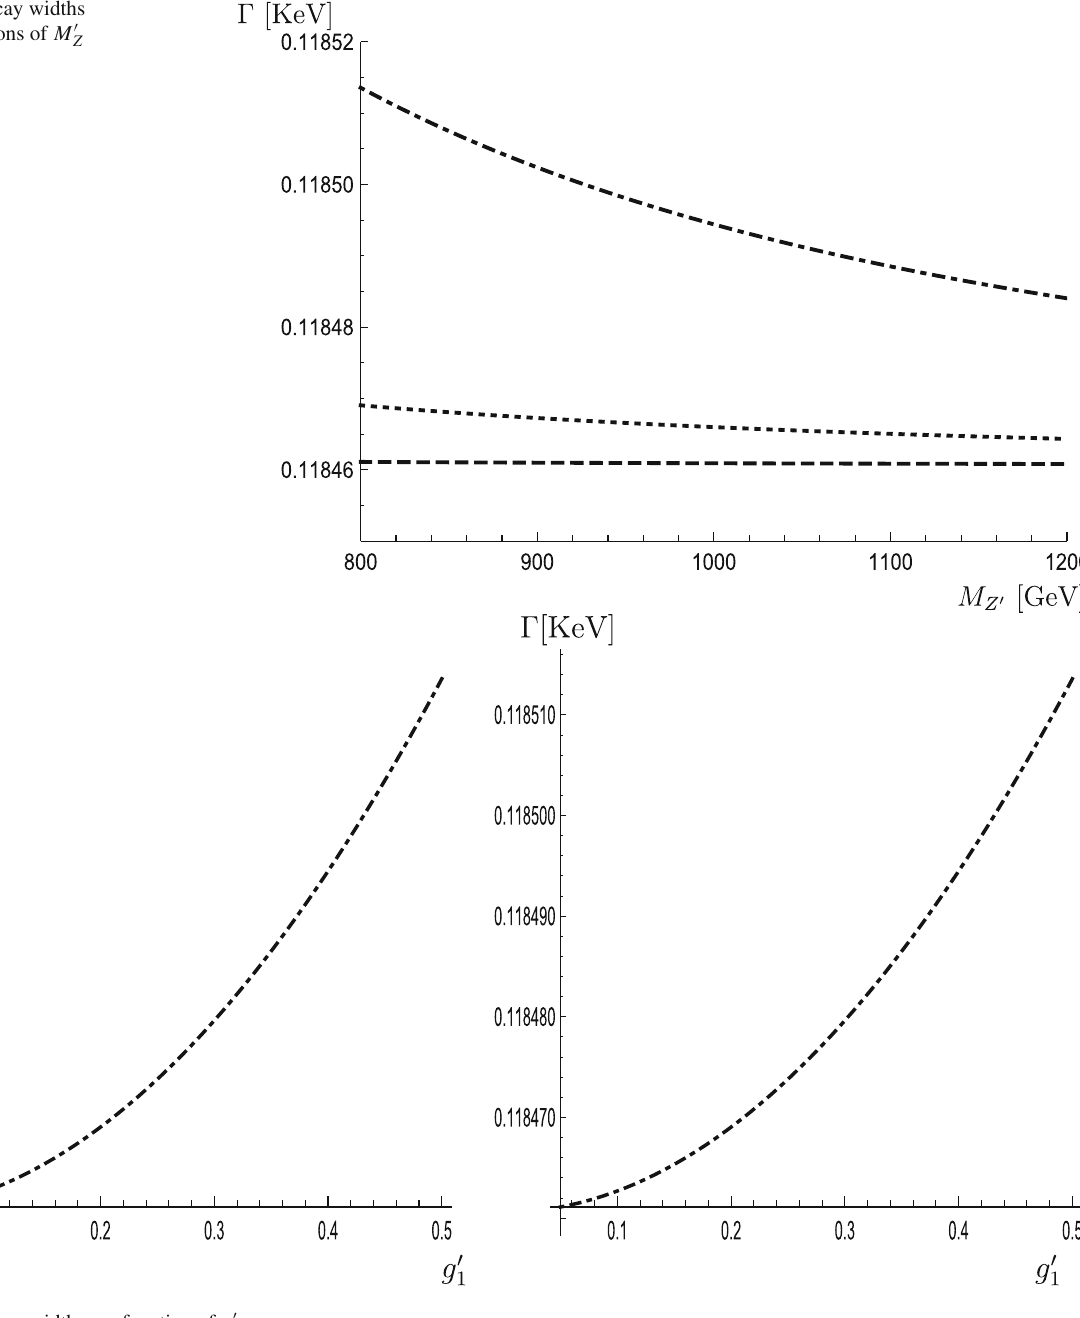
Fig. 15 The decay widths are function of g (cid:3) are proportional to g (cid:3)